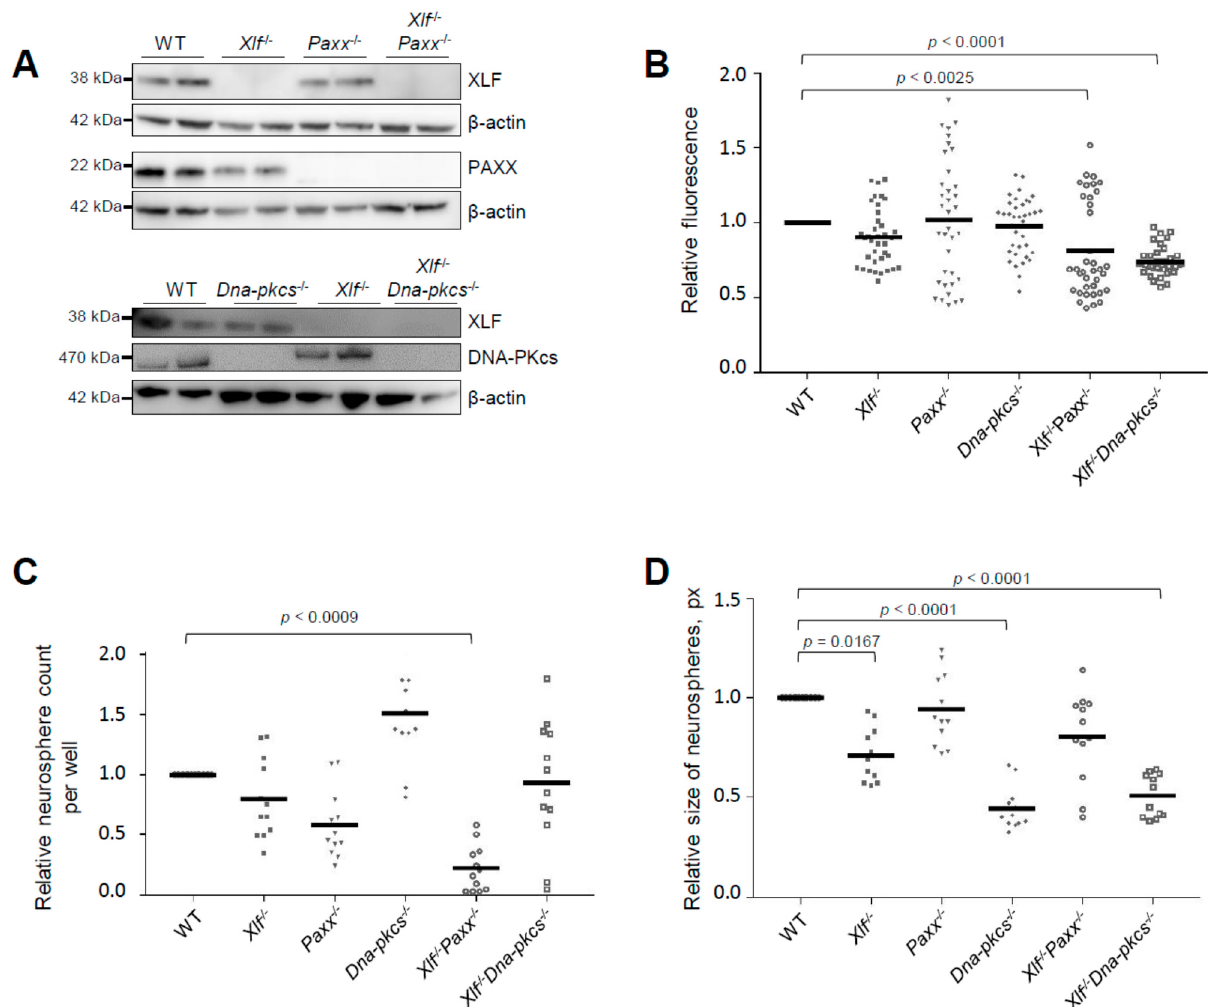
Figure 2. Proliferation and self-renewal capacity of NSPCs. ( A ) Western blot analysis confirmed the NSPCs’ genotype revealing no signal corresponding to XRCC4-like factor (XLF) in Xlf − / − , Xlf − / − Paxx − / − and Xlf − / − Dna-pkcs − / − NSPCs; no signal corresponding to PAXX in Paxx − / − and Xlf − / − Paxx − / − NSPCs; no signal corresponding to DNA-PKcs in Dna-pkcs − / − and Xlf − / − Dna-pkcs − / − NSPCs; β -actin was used as a loading control. Uncropped western blots are presented in Supplementary Figure S1. ( B ) Proliferation of NSPCs of indicated genotypes was assessed following 3 days in cell culture; it was expressed as fluorescence units normalized to wild type (WT) controls. Summary of six replicates per two clones, where each clone represents an independent mouse embryo, and three independent experiments (total n = 36). The horizontal bars represent the average. Significant differences were found between WT vs. Dna-pkcs − / − and WT vs. Xlf − / − Paxx − / − . Self-renewal capacity was determined at day 8 in culture by counting the number of neurospheres formed ( C ). Self-renewal was also assessed by ( D ) the size of the neurospheres was counted using pixels (px). Significant differences were found between WT vs. Xlf − / − as well as between Dna-pkcs − / − vs. Xlf − / − Dna-pkcs − / − samples. Summary of two replicates per clone, two clones per genotype representing an independent mouse embryo each; three independent experiments ( n =12). The horizontal bars represent the average values. Detailed statistical analysis for NSPC proliferation, Figure 2B. WT vs. Xlf − / − (**, p =